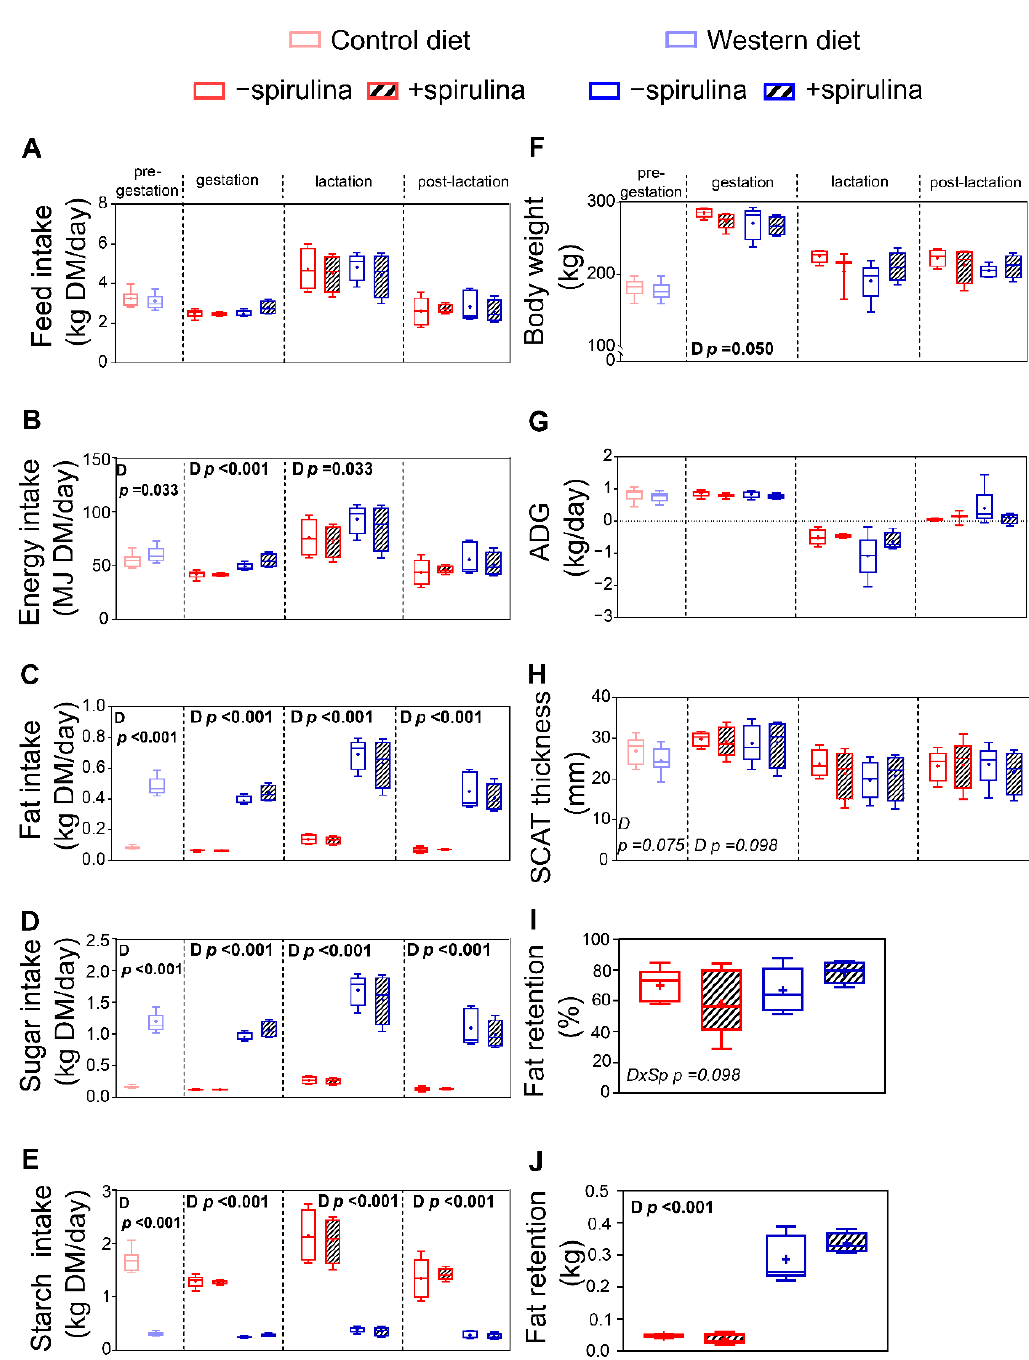
Figure 2. Effects of diet and spirulina supplementation on feed intake and growth performance of the sows during pre-gestation, gestation, lactation, and post-lactation, as well as body fat retention determined one week before expected farrowing. Experimental sows received either a control (CTR) or Western (WES) diet throughout all four experimental periods, while spirulina supplementation was started for half of CTR/WES groups at the end of the pre-gestation period. Differences in ( A ) feed, ( B ) energy, ( C ) fat, ( D ) sugar, and ( E ) starch intake during the four experimental periods; ( F ) body weight (BW) of experimental animals at the end of each period; ( G ) average daily gain (ADG) of experimental animals during each experimental period; ( H ) subcutaneous adipose tissue (SCAT) thickness at the end of each experimental period; ( I ) relative fat retention and ( J ) absolute fat retention one week before expected farrowing calculated from fat intake and fecal fat excretion during 24 h. Sp: spirulina; D: diet. Data are presented in boxplots with Spear style whiskers (min to max).